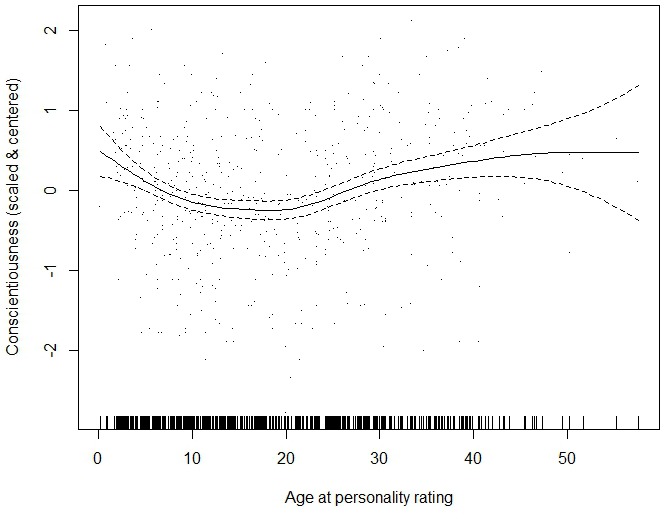
Generalized additive model of conscientiousness and age at personality rating.The carpet and scatter plot present the distribution of observations over which the best fit smoothed regression line is plotted with the 95% confidence region.